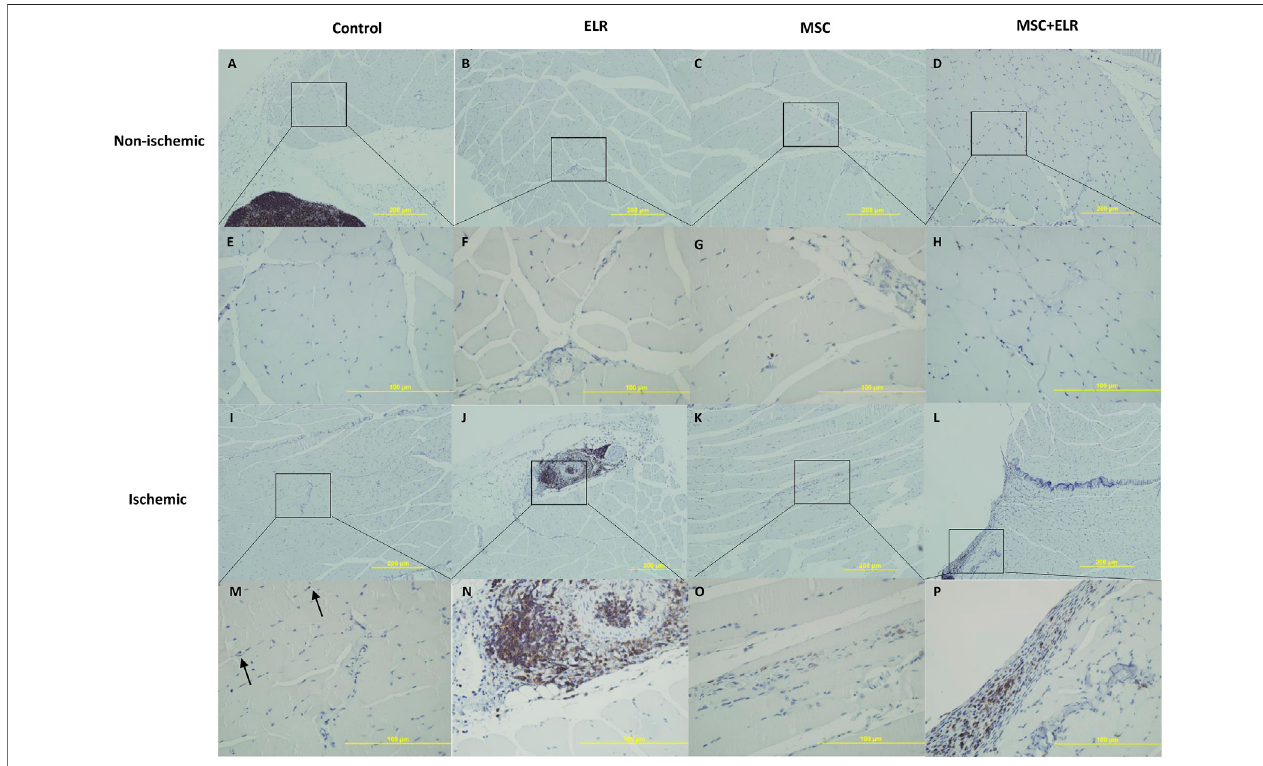
FIGURE 3 | Immunohistochemical staining for CD45 to detect immune cells. Representative images of ischemic and non-ischemic hindlimbs stained for CD45 detection after 21 days post surgery are represented. Positive staining is indicated by the dark brown areas. (A – D) and (I – L) 10X ampli fi cation. (E – H) and (M – P) 40X ampli fi cation. ELR: elastin-like recombinamer; MSC: mesenchymal stromal cells. Arrows point out CD45 positive cells.